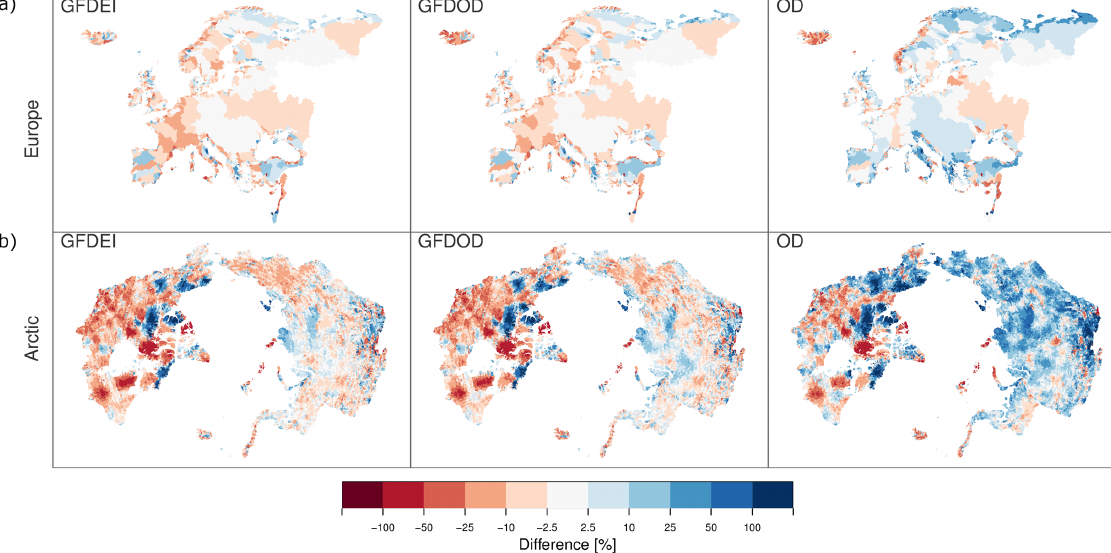
Figure 6. Relative percentage difference of the specific runoff in the upstream area from GFDCL for each catchment of (a) E-HYPE and (b) Arctic-HYPE, with the different data sets (right to left panels) GFDEI, GFDOD and